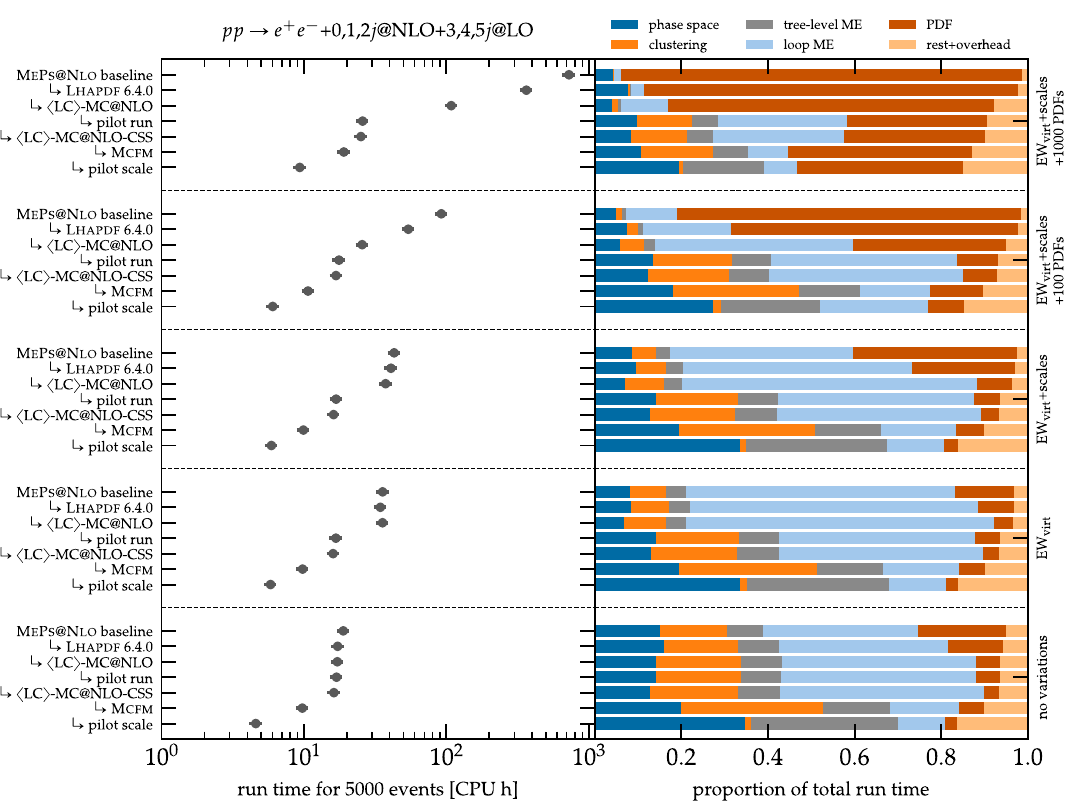
Fig. 3 Reduction in overall run time for different performance improvements, combined with the breakdown of the overall run time into a high-level calculation composition. The timing is assessed by producing 5000 partially unweighted particle-level events for pp → e + e − + 0 , 1 , 2 j @NLO + 3 , 4 , 5 j @LO and 1000 particle-level events for pp → t ¯ t +